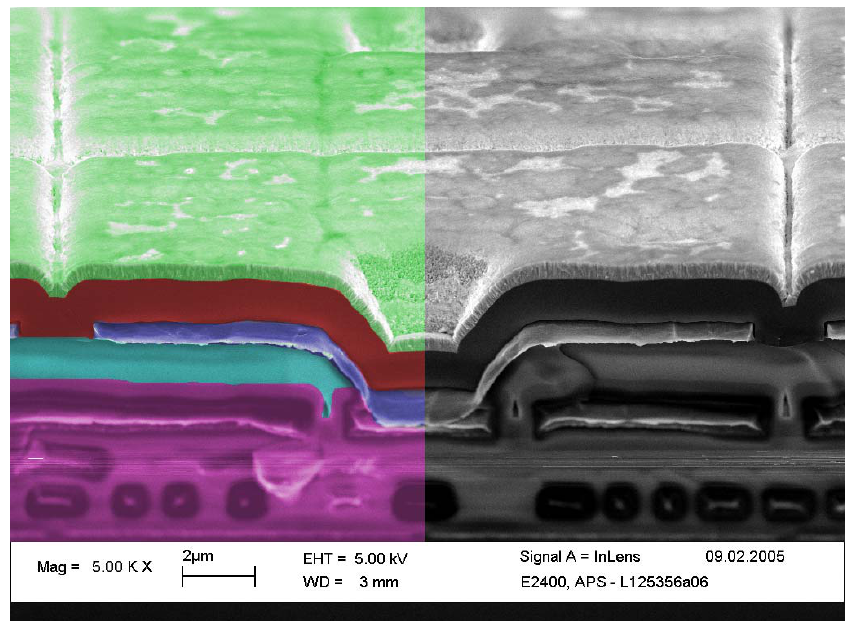
Figure 1. REM recording of a TFC